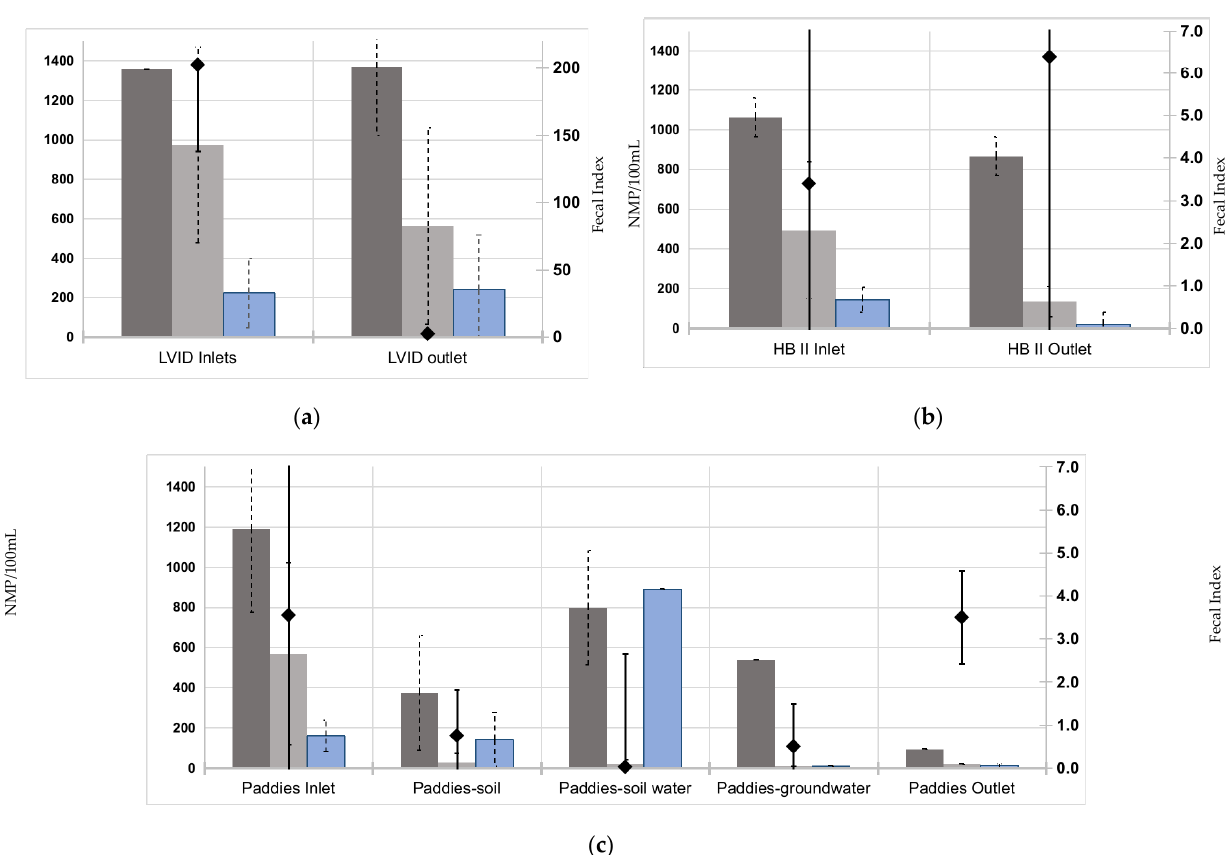
Figure 2. Mean values of counts (and standard deviation) of Total Coliforms ( ■ ), Fecal Coliforms ( ■ ), Fecal Enterococci ( ■ ), expressed in MPN/100mL, and Fecal Index ( ◆ ) at the inlet and outlet of: ( a ) LVID; ( b ) Block II (HB II); ( c ) rice paddies of Block II, including at the soil, soil water and ground-water.